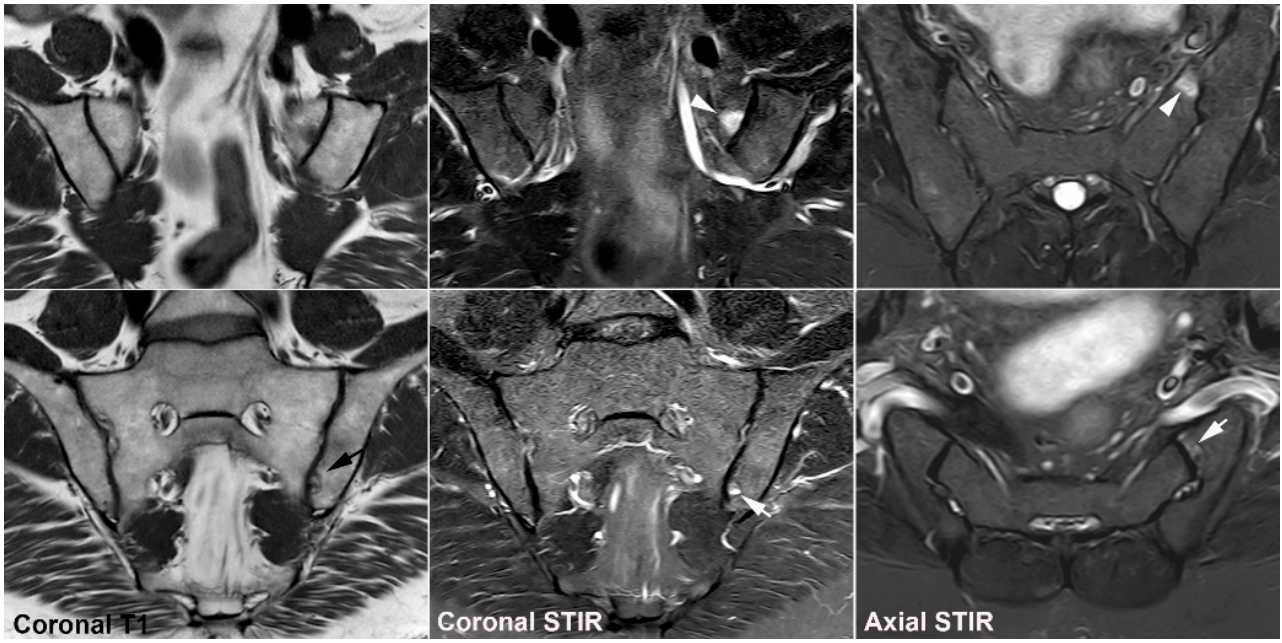
Figure 18. Strain-related SIJ changes. MRI in a 53-year-old sports active man, semi-coronal T1 to the left, semi-coronal STIR in the middle, and semi-axial STIR to the right with the upper images row displaying the anterior middle part and the lower image row the inferior part of the joints. There is subchondral BME anteriorly in the sacrum corresponding to the strain-related joint area (arrowheads) and a subchondral cyst with fluid signal inferiorly in the left ileum with slight surrounding fat deposition (black arrow on T1); no erosions or fat deposition characteristic of axSpA.